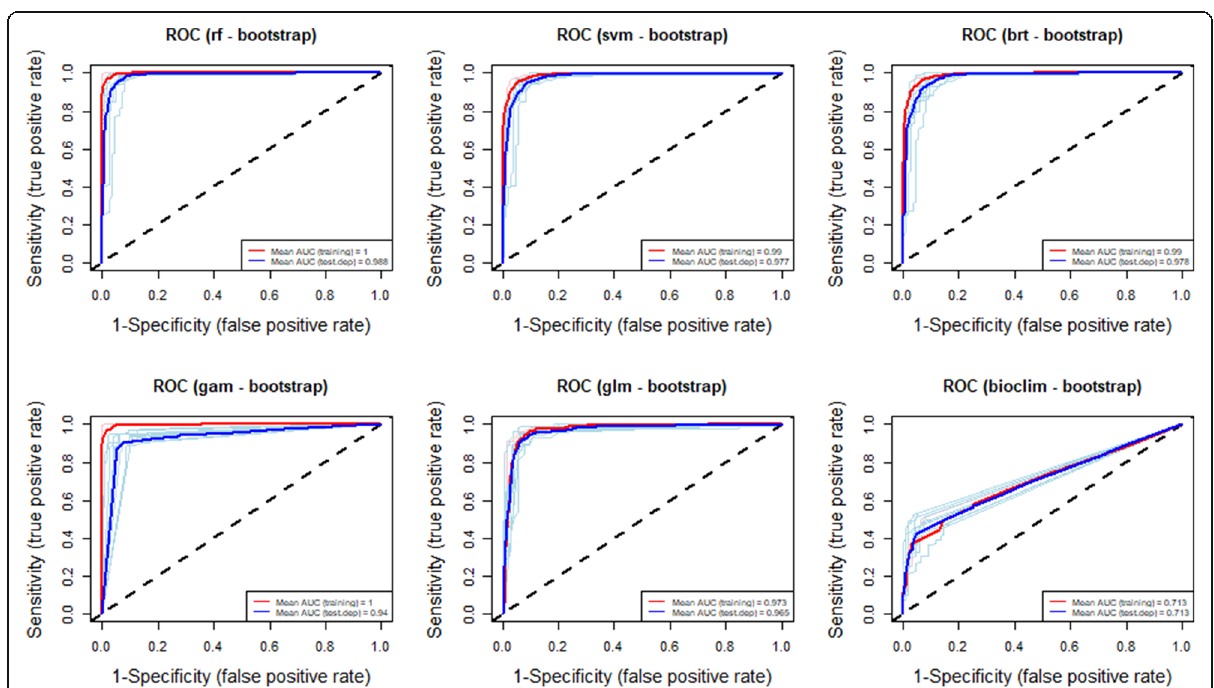
Fig. 3 Receiver operator characteristics (ROC) curve using bootstrap replication method for different SDMs. Sensitivity (true positive rate) of the vertical line and 1-specificity (false positive rate) of the horizontal line describe the proportion of correctly and incorrectly classified samples. The red and blue curves represent the mean of AUC using training and test data